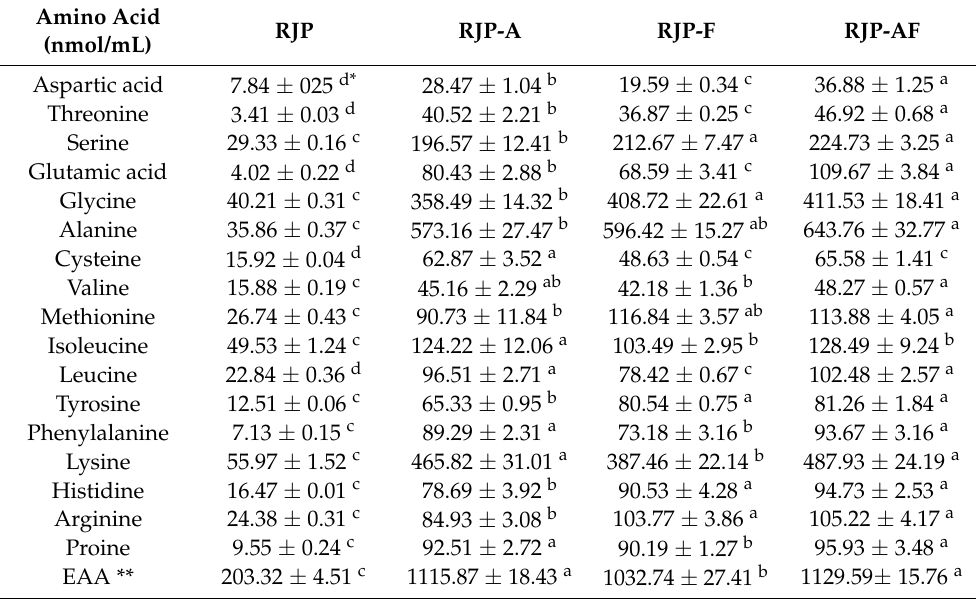
Table 2. The contents of free amino acids of RJP and RJP hydrolysates.